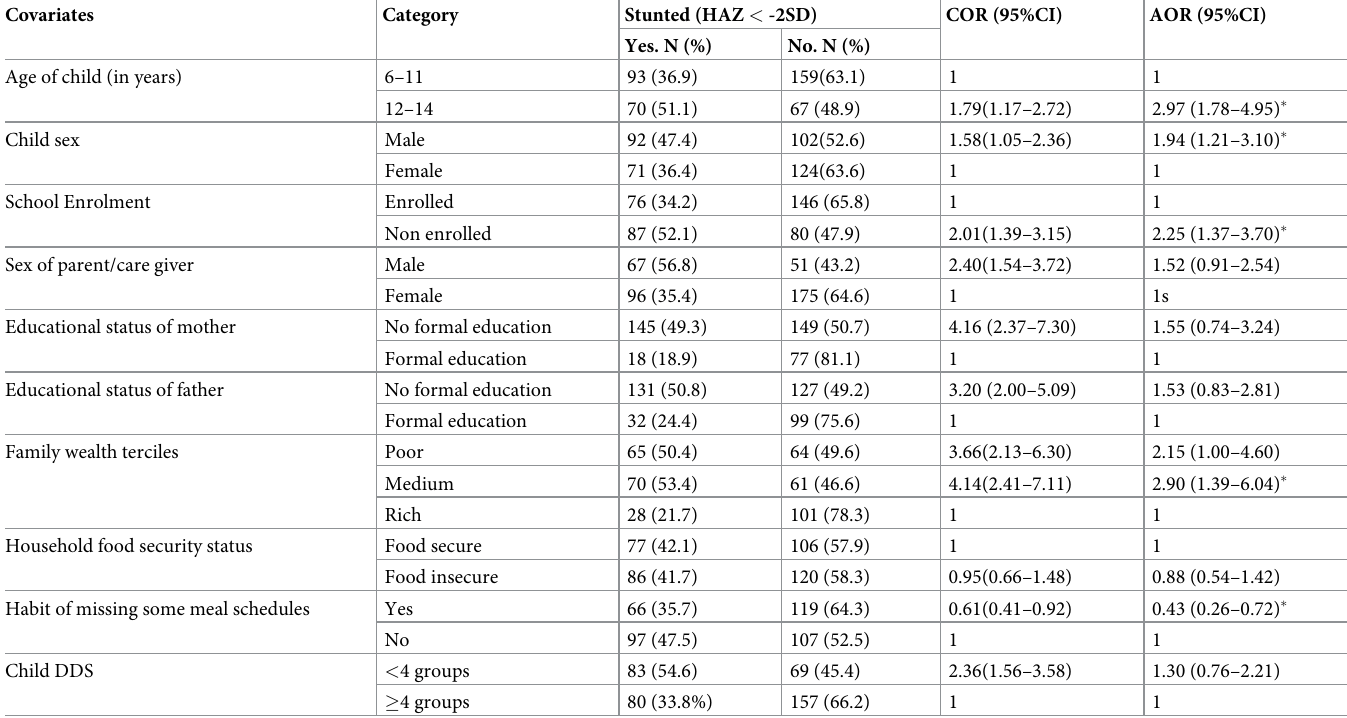
Table 3. Factors associated with stunting among school-age children (n = 389), Arba Minch HDSS, Sothern Ethiopia, 2017. Covariates